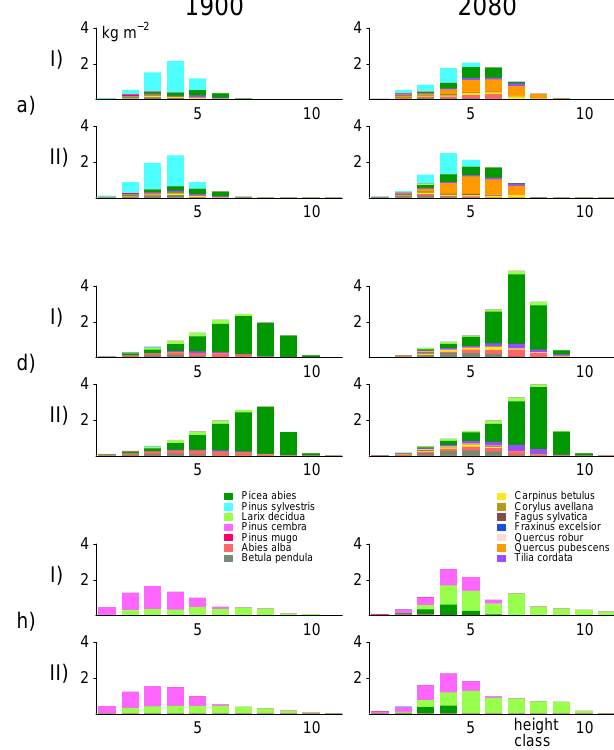
tion years 1900 and 2080. Carbon mass per tree species is plotted against tree height classes for (I) LPJ-GUESS using 400 replicate patches and (II) LPJ-GUESS-G (GAPPARD method used on LPJ- GUESS). Height class 1: trees of 2–6m height; height class 2: trees of 6–10m height, and so